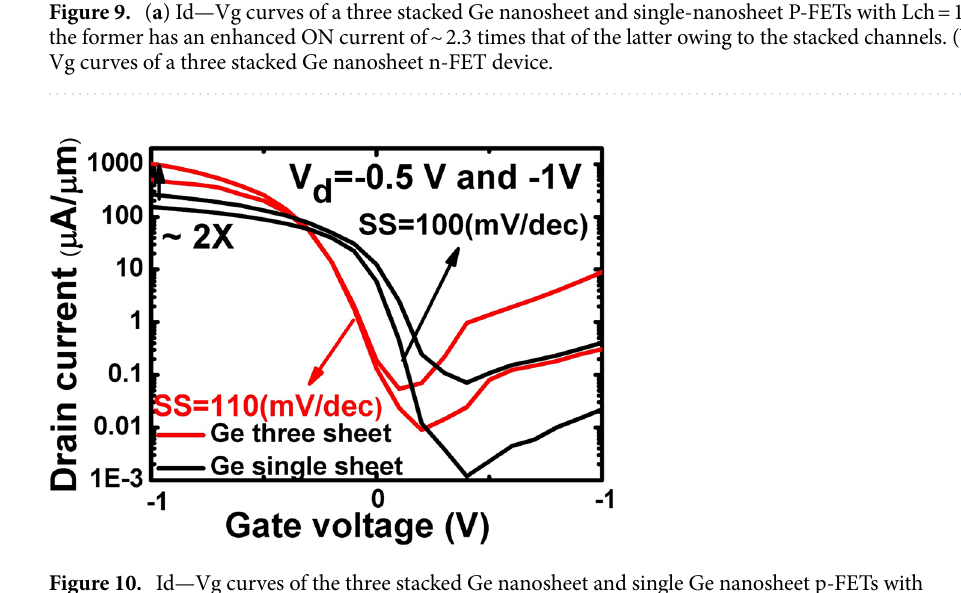
Figure 10. Id—Vg curves of the three stacked Ge nanosheet and single Ge nanosheet p-FETs with Lch = 1.0 µm; the former has an enhanced ON current of ~ 2.0 times that of the